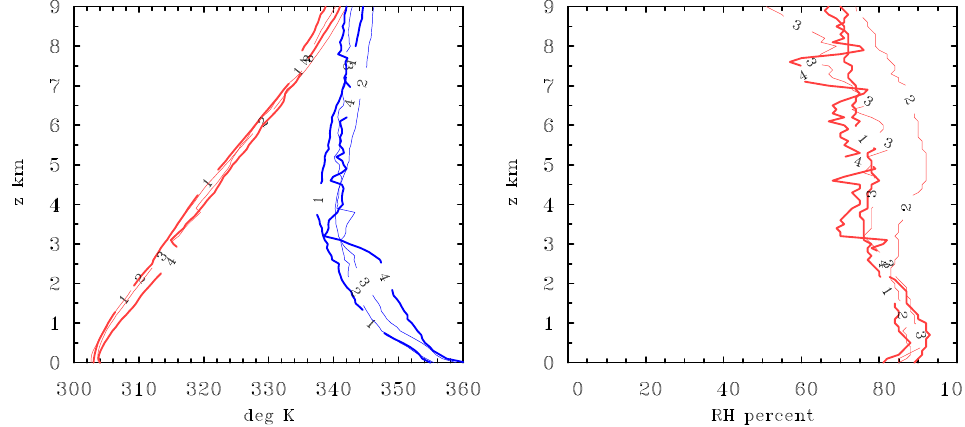
Fig. 5. Vertical profiles of the system-averaged θ v and θ e (left panel) and RH (right panel) for all four days of Nuri. The thick curves mark the first and last days of the sequence. Numbers on curves refer to the particular day of Nuri: Nuri1, Nuri2, etc. See text for further details.